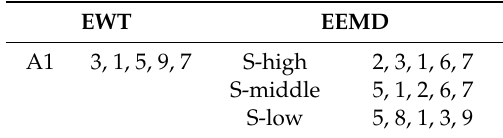
Figure 10. Importance of high frequency, intermediate frequency, and low frequency signal by EEMD characteristic of “Yangdong Line.” Table 2. Input factors for random forest analysis selection of “Yangdong Line.”